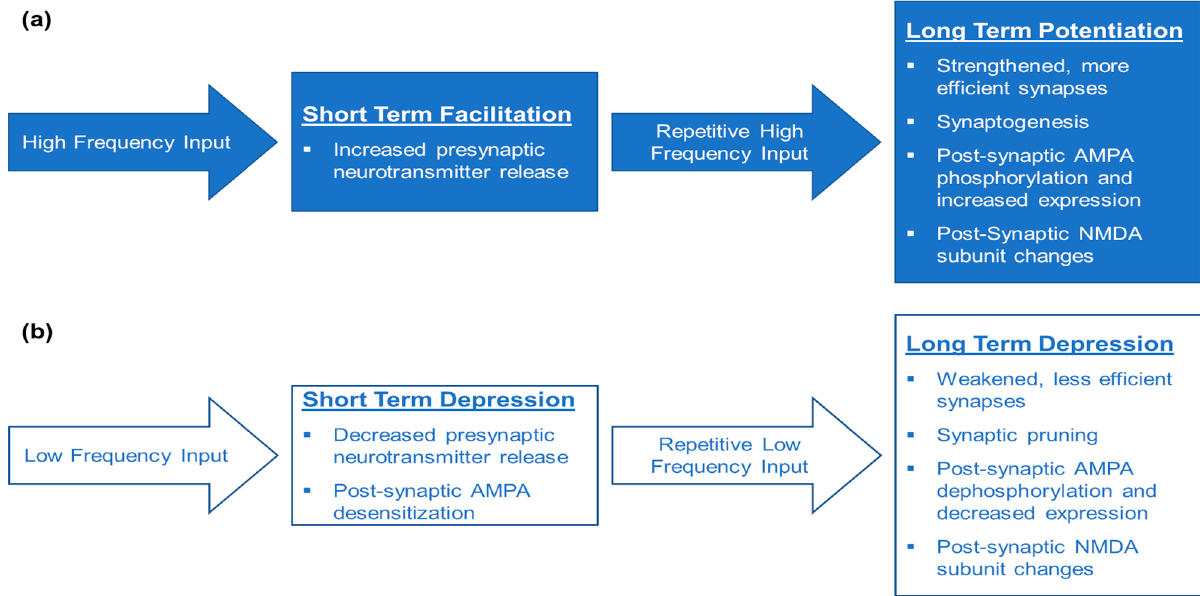
Figure 1. Key Characteristics of Neural Plasticity based on Hebbian learning. ( a ) Synaptic connections become stronger and more efficient following high frequency and repetitive input. This strengthening is known as either short-term facilitation or long-term potentiation. On a molecular level, single bouts of high frequency input result in increased neurotransmitter release, while repetitive bouts of high frequency input increases synaptogenesis, synaptic efficiency by modulating post- synaptic AMPA and NMDA receptor subunit expression and phosphorylation. These cellular and molecular changes are thought to underlie learning and memory, whether that be for episodic memory or refinement of motor control. ( b ) Synaptic connections can become weaker and less efficient after low frequency input. An episode of low frequency input results in short-term depression and is associated with decreased presynaptic neurotransmitter release, desensitization of AMPA receptors. Repetitive low frequency input results in long-term depression, which results in weakened, less efficient synapses, pruning of unused synapses, as well as dephosphorylation of AMPA receptors and changes in NMDA receptor subunit composition. Similarly to long-term potentiation, short- and long-term depression are also crucial aspects of learning and memory as unnecessary, redundant, and inefficient connections get pruned away to optimize the